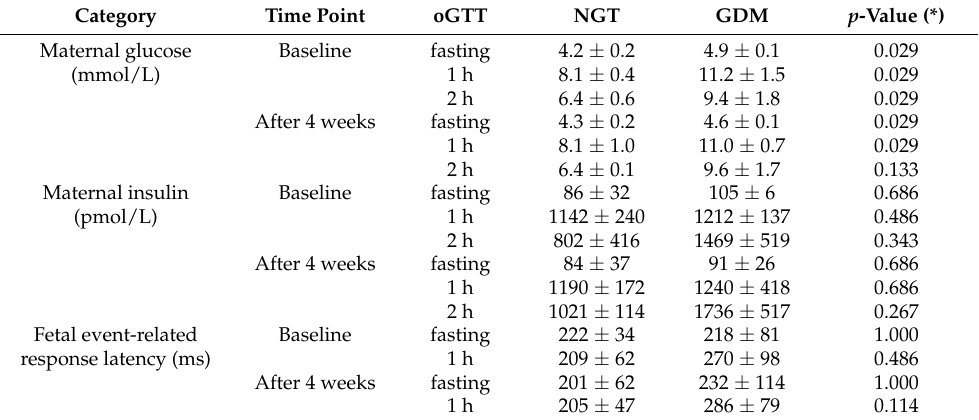
Table 2. Metabolic characteristics of study participants. Data are given as mean ± standard deviation.